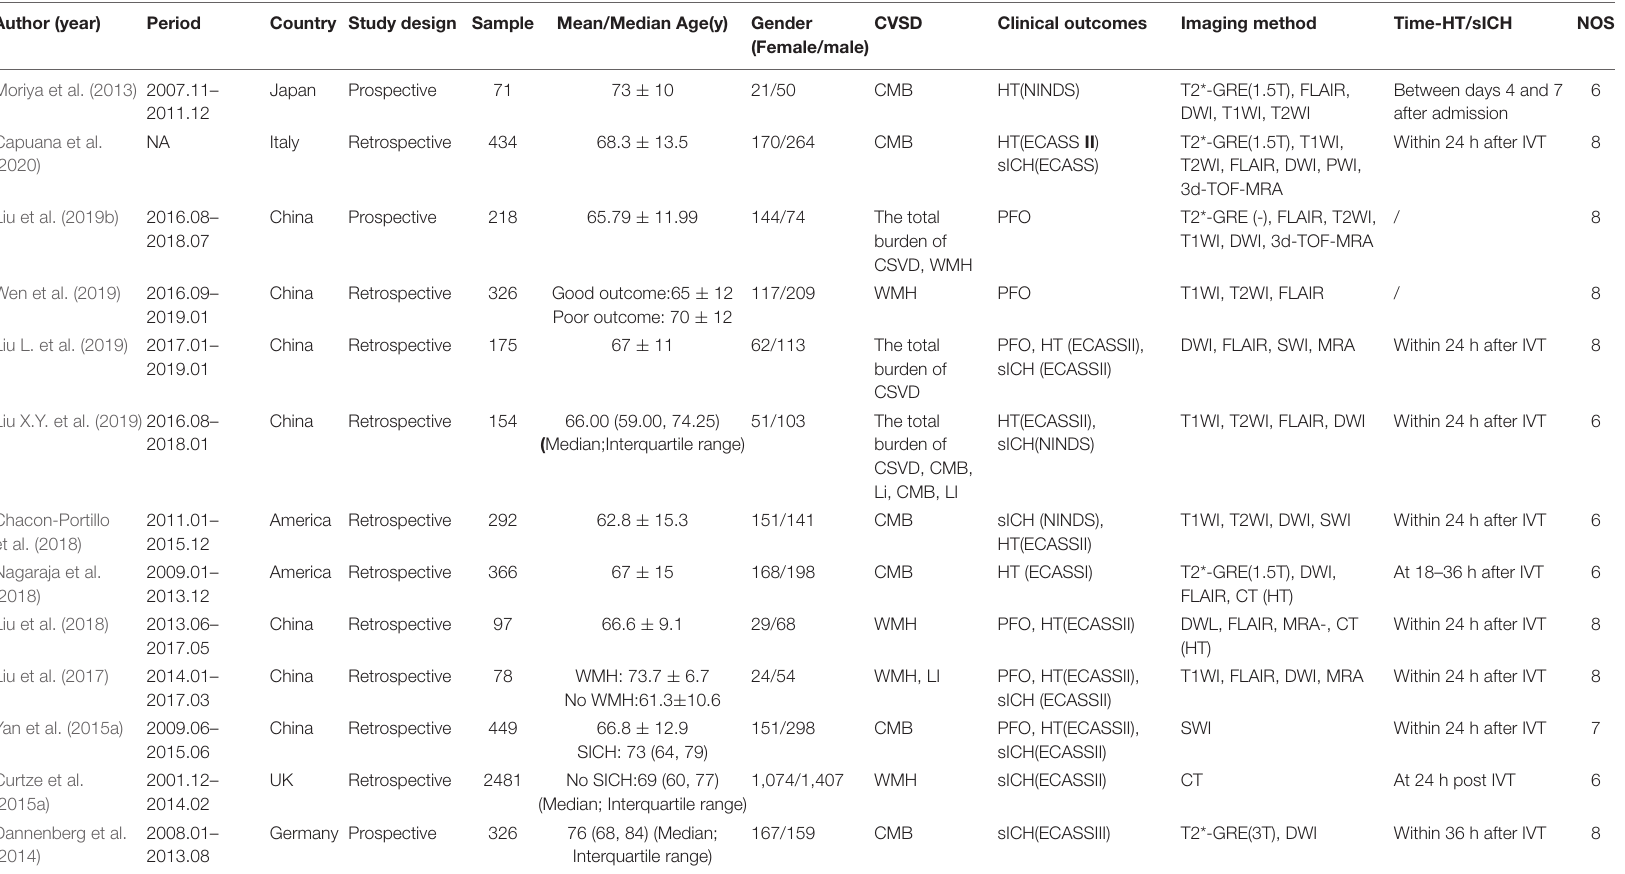
TABLE 1 | Characteristics of the studies in the